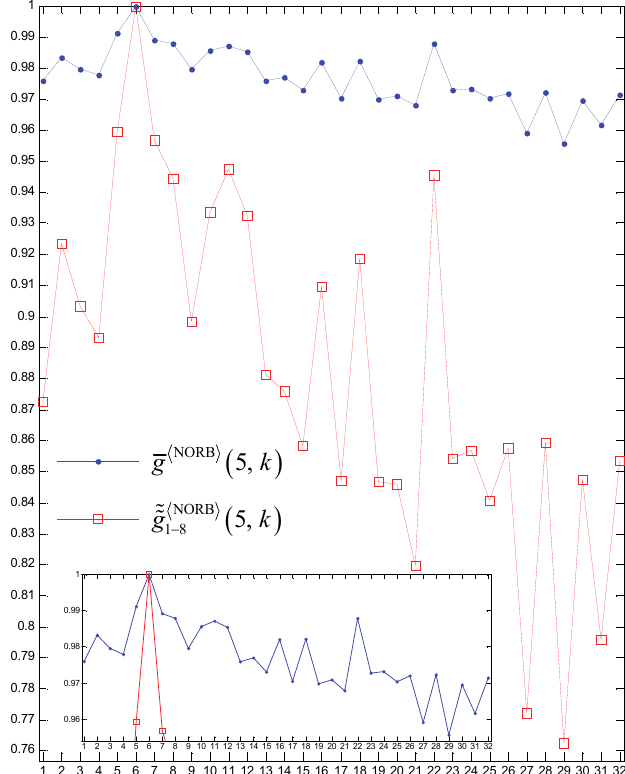
Fig. 17. The normalized averaged RERD (16) and the normalized averaged 5 N  on NORB. Maxima coincide at k = 6. final-epoch RERD (17) by ConvL A weak consistency of these polylines and those ones in Fig. 9 is